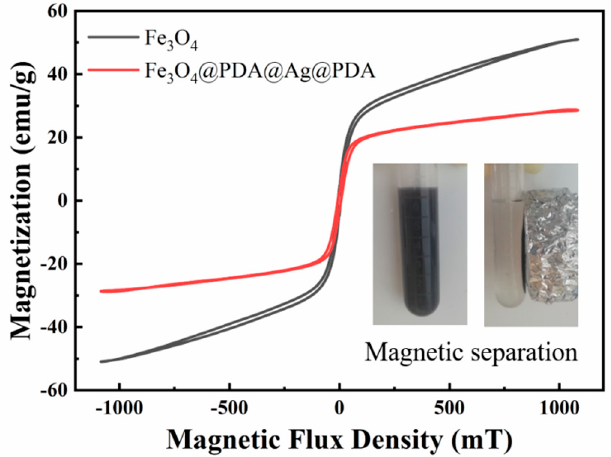
Figure 8. The room temperature hysteresis loop of Fe 3 O 4 and Fe 3 O 4 @PDA / Ag / PDA nanospheres and the inset shows the optical image of magnetic separation process.